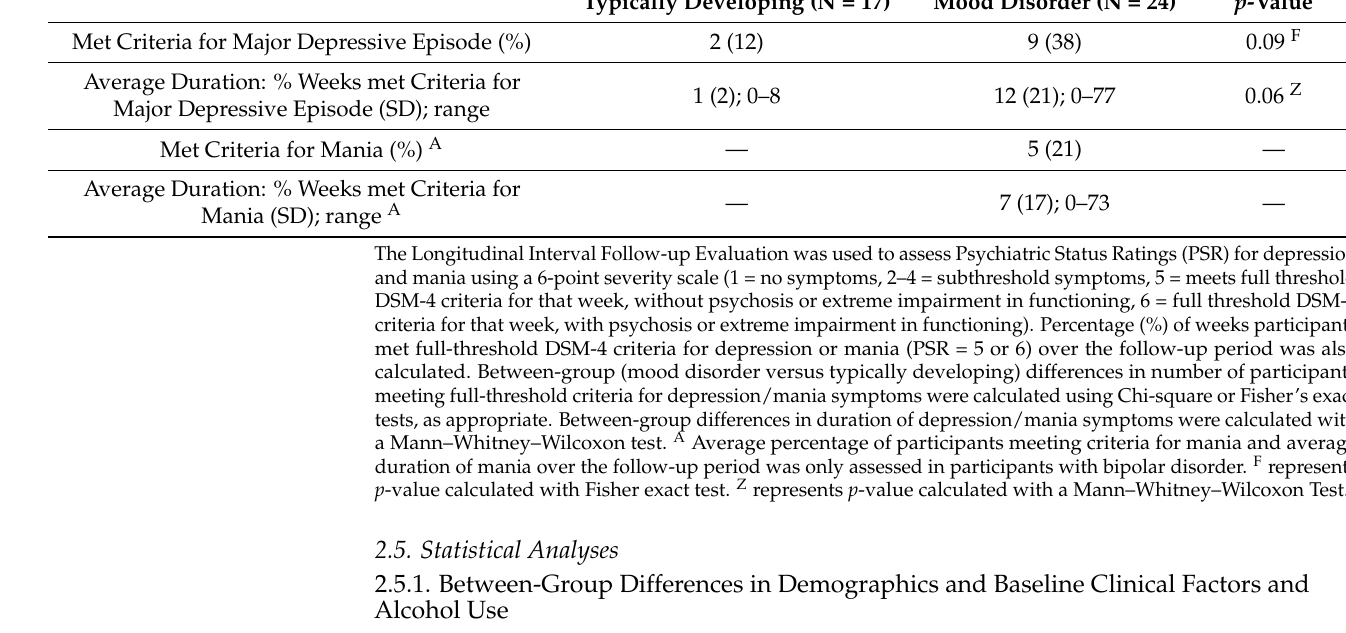
Table 3. Psychiatric Status Ratings for depression and mania over the follow-up period. Typically Developing (N = 17) Mood Disorder (N = 24) p -Value Met Criteria for Major Depressive Episode (%) 2 (12) 9 (38) 0.09